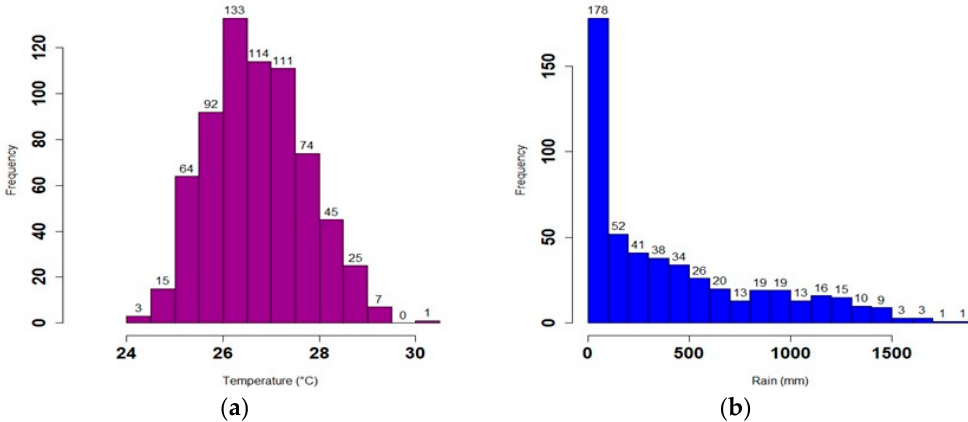
Figure 2. Histograms of monthly temperature frequency, the monthly temperature mean value of 26 °C has higher frequency of observation ( a ) and monthly rainfall ( b ) overall frequency showing that the monthly rainfall value of 0.1–100 mm has higher frequency of observation at Conakry Airport station.